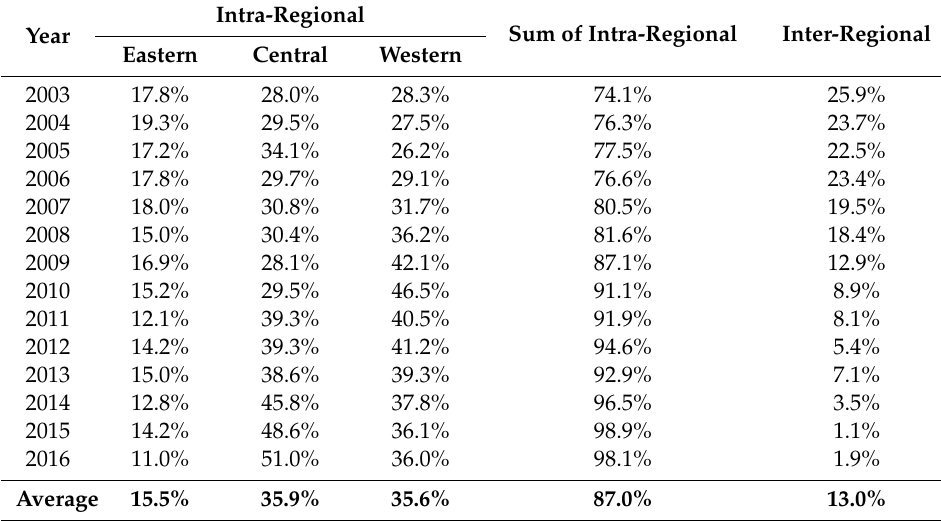
Table 4. Contribution decomposition of Theil index (2003–2016).